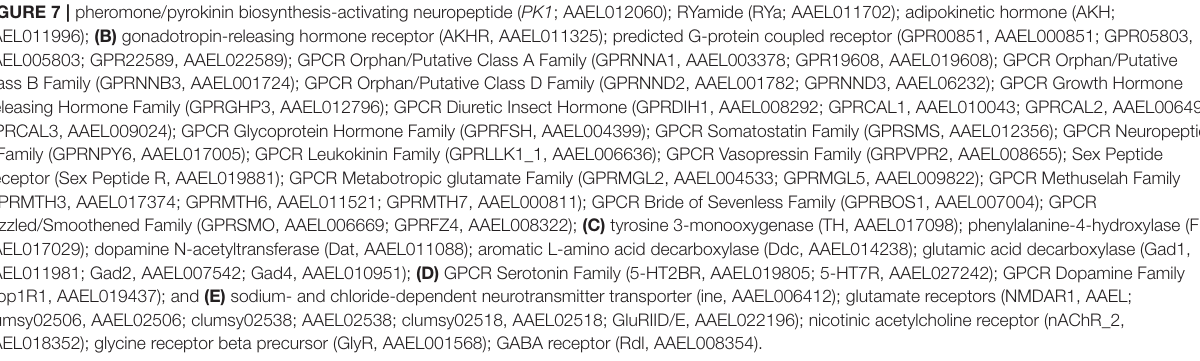
FIGURE 7 | pheromone/pyrokinin biosynthesis-activating neuropeptide ( PK1 ; AAEL012060); RYamide (RYa; AAEL011702); adipokinetic hormone (AKH; AAEL011996); (B) gonadotropin-releasing hormone receptor (AKHR, AAEL011325); predicted G-protein coupled receptor (GPR00851, AAEL000851; GPR05803, AAEL005803; GPR22589, AAEL022589); GPCR Orphan/Putative Class A Family (GPRNNA1, AAEL003378; GPR19608, AAEL019608); GPCR Orphan/Putative Class B Family (GPRNNB3, AAEL001724); GPCR Orphan/Putative Class D Family (GPRNND2, AAEL001782; GPRNND3, AAEL06232); GPCR Growth Hormone Releasing Hormone Family (GPRGHP3, AAEL012796); GPCR Diuretic Insect Hormone (GPRDIH1, AAEL008292; GPRCAL1, AAEL010043; GPRCAL2, AAEL006490; GPRCAL3, AAEL009024); GPCR Glycoprotein Hormone Family (GPRFSH, AAEL004399); GPCR Somatostatin Family (GPRSMS, AAEL012356); GPCR